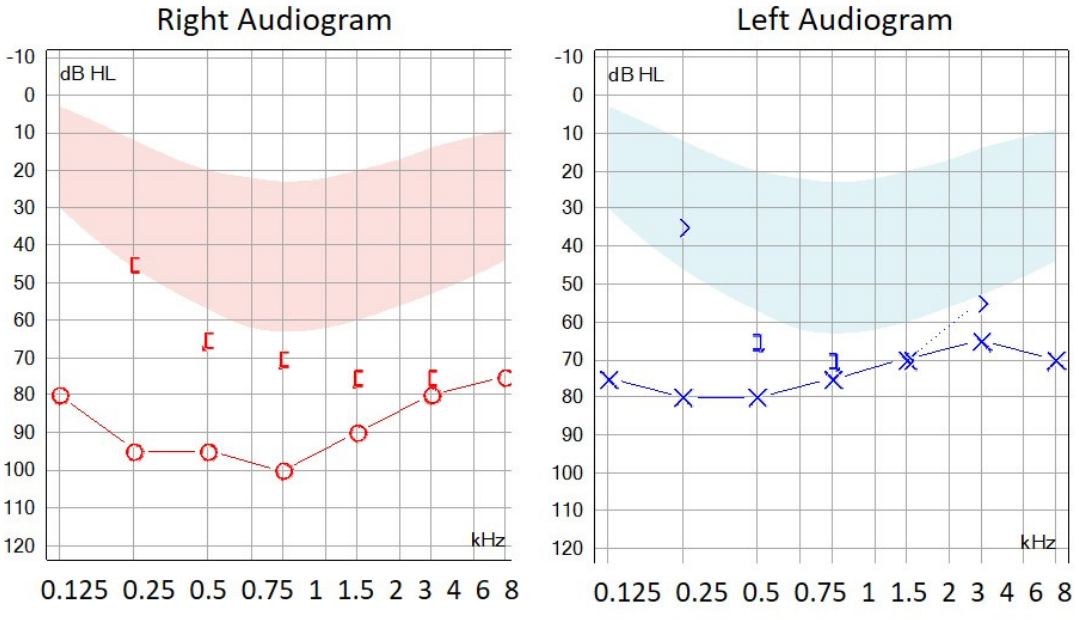
Figure 3. Audiogram performed in patient 40431 harboring the c.1463_1474dup/p. (Val491_Pro492insLeuIleThrVal) variant in the WFS1 gene.